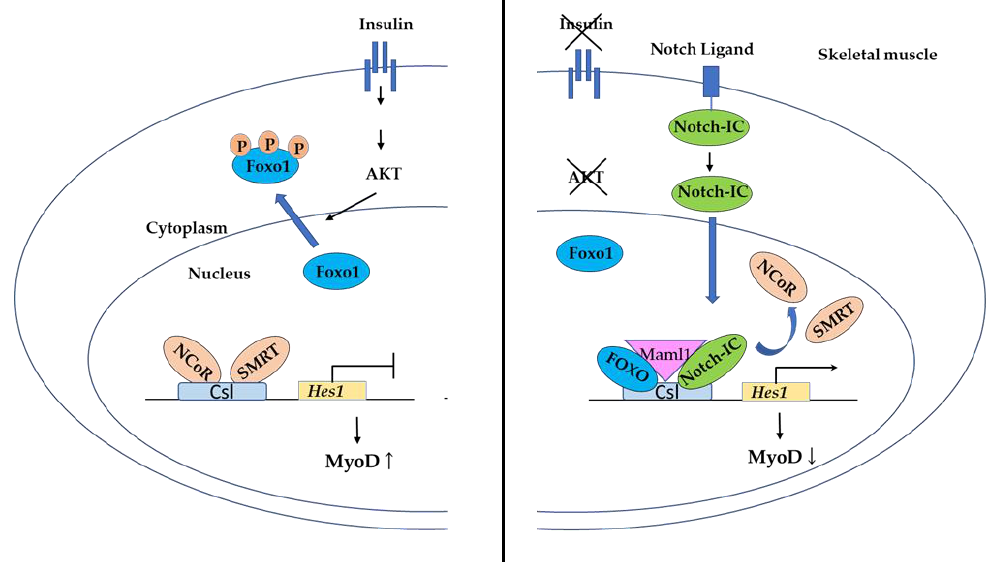
Figure 10. MyoD regulation by Notch/Foxo1 binding to Csl. Notch ligand binding to the Notch receptor releases the cellular domain of Notch (Notch-IC). The activated Notch-IC binds to the DNA- binding protein Csl. Activated Foxo1 also binds to Csl. Hairy and Enhancer of split ( Hes ) gene is a Csl target gene. Notch/Foxo1 activates Hes1 transcription, leading to suppressing myogenic determination ( MyoD ) gene transcription. Nuclear corepressor (NCoR) and silencing mediator for retinoid and thyroid hormone receptor (SMRT) are transcription corepressors and mastermind-like 1 (Maml1) is a coactivator of